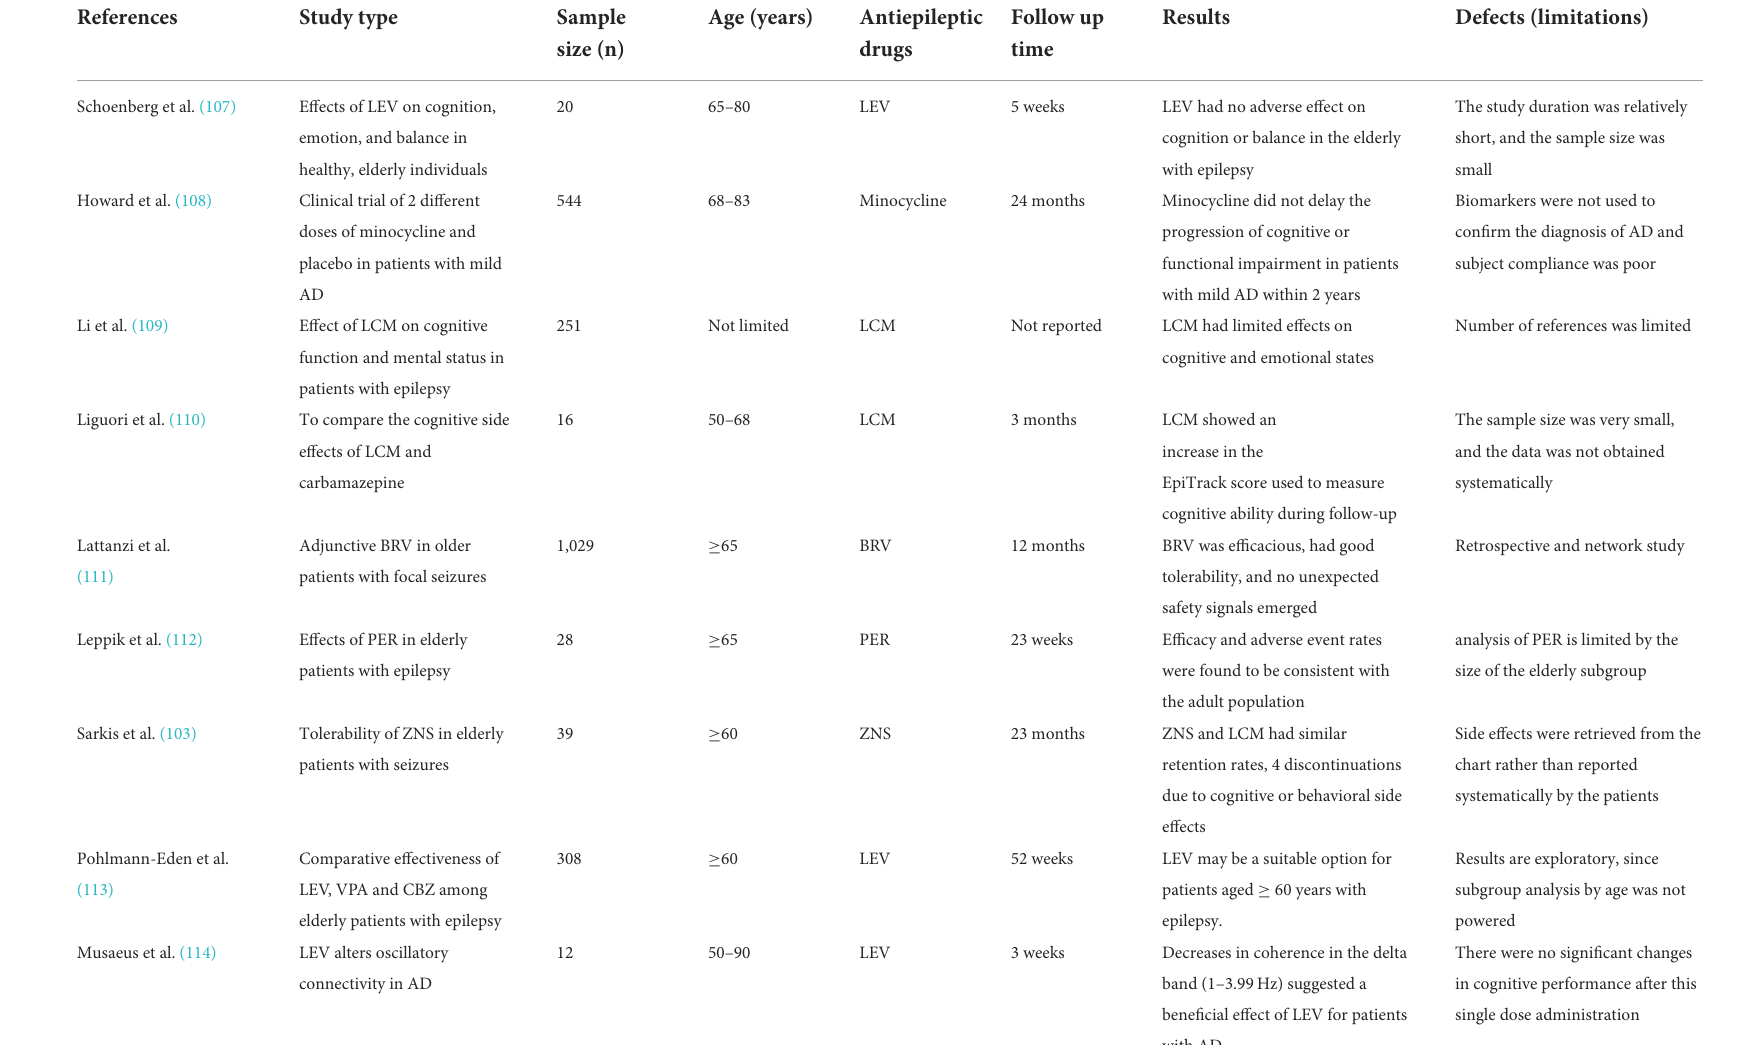
TABLE 2 Effects of new antiepileptic drugs on